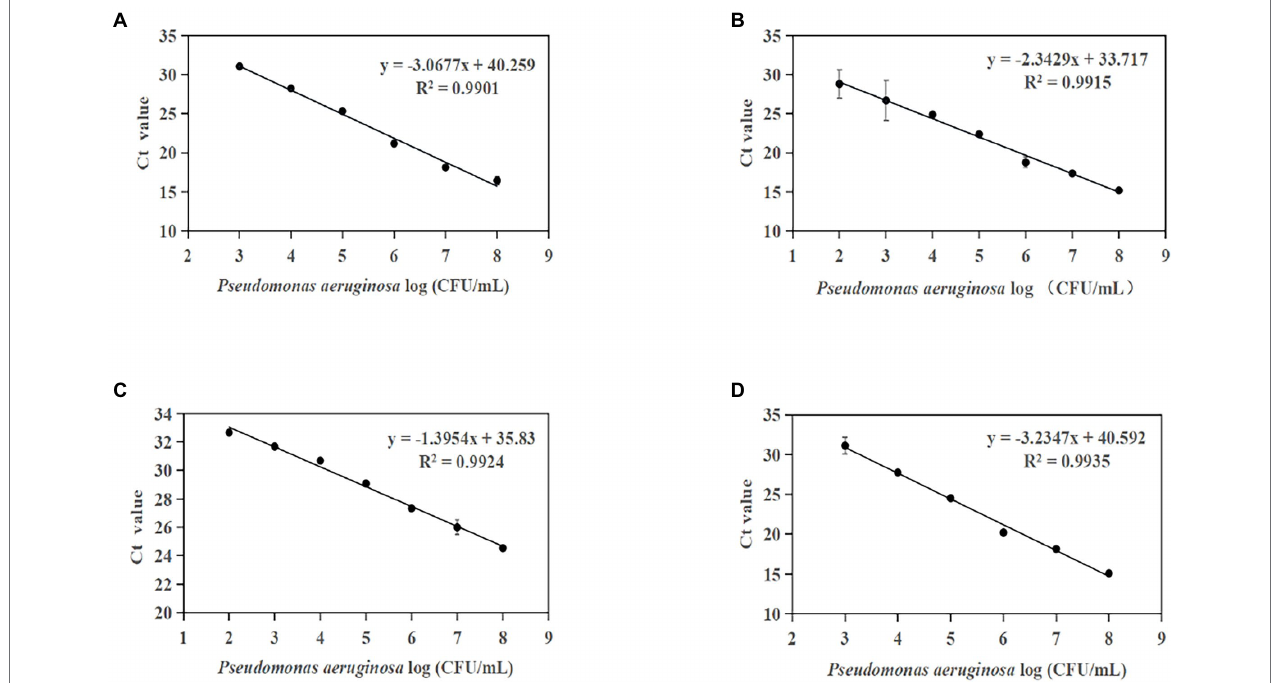
FIGURE 4 | Standard curves established by plotting cycle threshold (Ct) values against the log numbers of P. aeruginosa in pure culture. (A) Primer set PA12 in a range of 10 3 –10 8 CFU/ml; (B) primer set PA13 in a range of 10 2 –10 8 CFU/ml; (C) primer set PA14 in a range of 10 2 –10 8 CFU/ml; and (D) primer set PA15 in a range of 10 3 –10 8 CFU/ml.